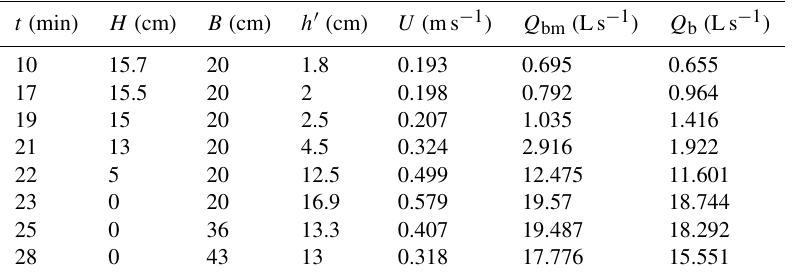
Figure 14. Simulated overflow rates. Table 3. Numerically calculated breach discharge and estimated values